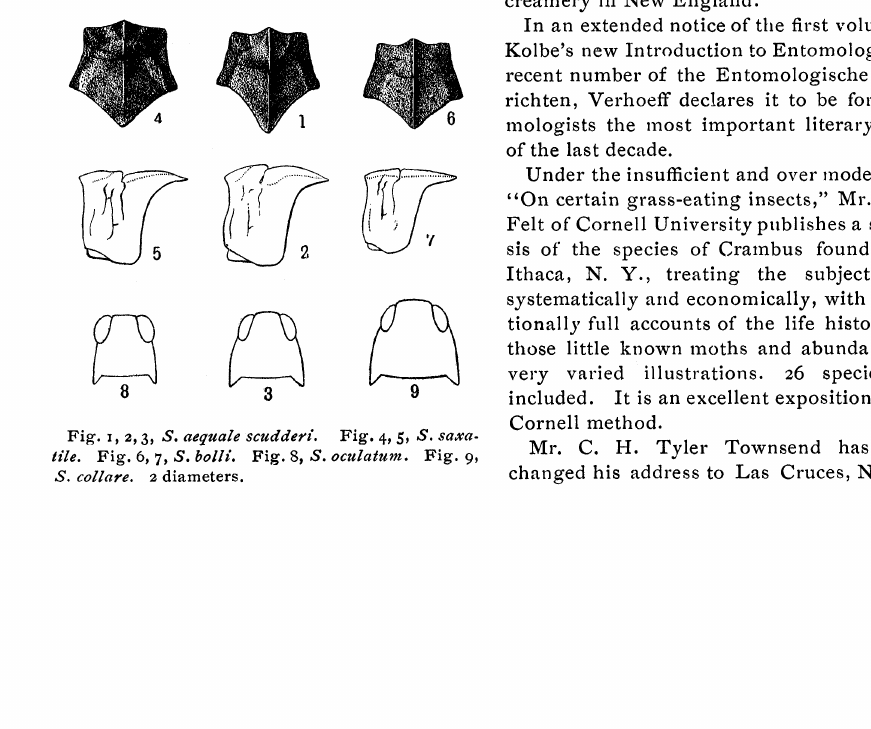
Fig. x, 2, 3, S. aequale scudderi. Fig. 4, 5, S. saxa. tile. Fig. 6, 7, S. bolli. Fig. 8 S. oculatum. :Fig. 9, S.